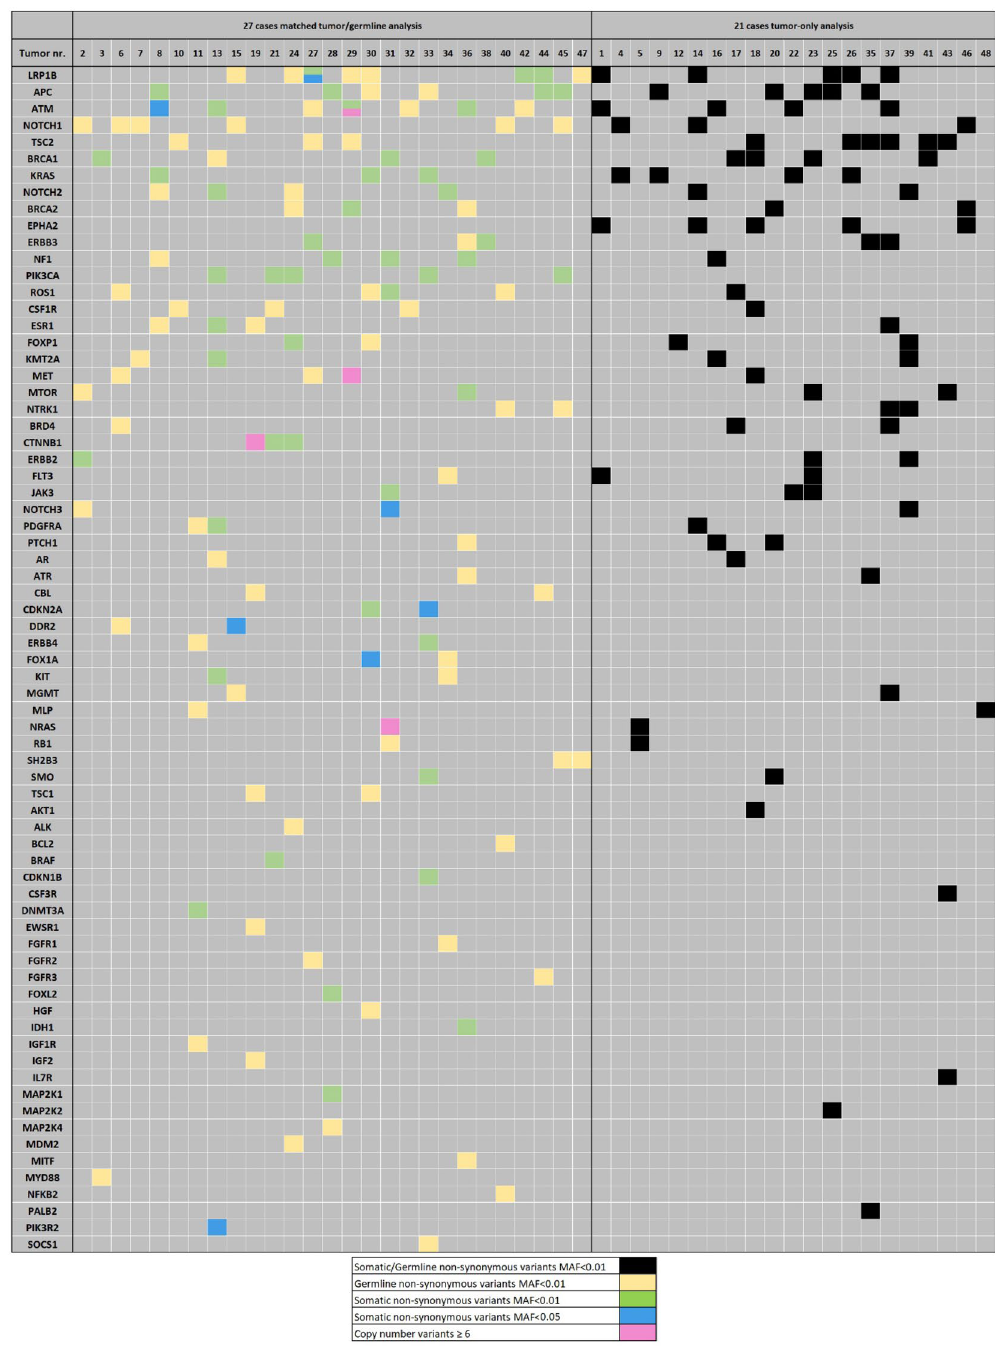
Figure 2. Sequence variants identified in 48 ITACs, 27 by tumor/germline and 21 by tumor-only bioinformatic analysis. Affected genes are presented in order of